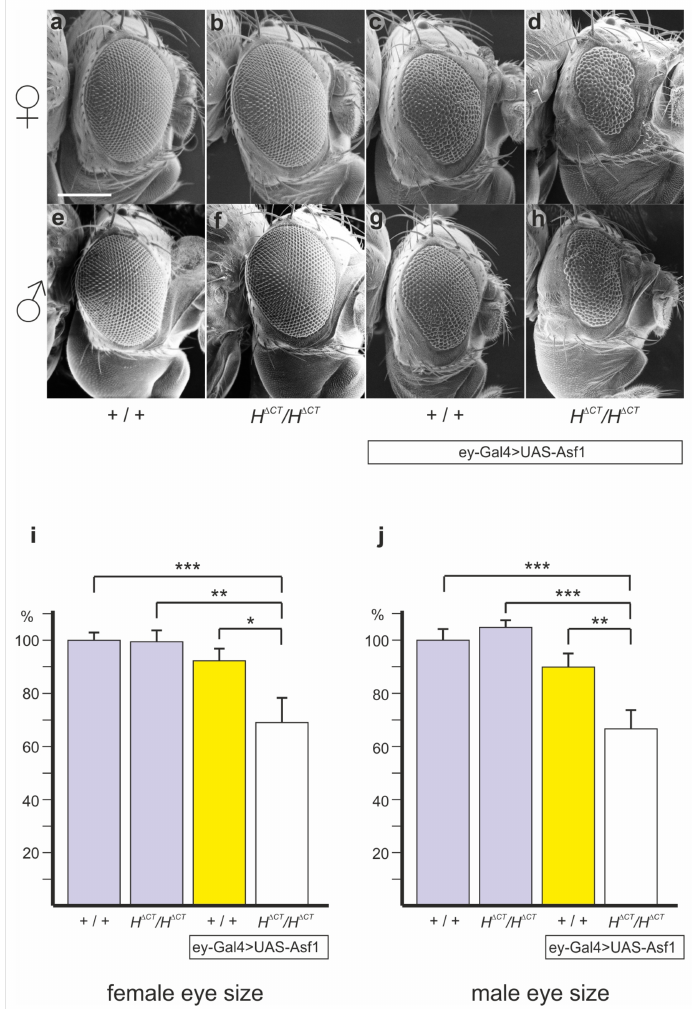
Figure 8. Eye size reduction induced by ectopically expressed Asf1 is enhanced in the H ∆ CT back- ground. ( a – h ) Scanning electron micrographs from female and male fly heads of the indicated genotype. Note the eye size reduction upon tissue-specific induction of Asf1 ( c , d , g , h ). Scale bar, 200 µ m ( a – h ). ( i , j ) Quantification of the eye size from five female flies of the indicated genotype using Image J. Controls are the homozygous y 1 w 67c23 ( a ) and H ∆ CT flies ( b ) (lilac bars). Eye-specific expression of Asf1 reduced eye size ( c ) (yellow bar), which was significantly enhanced in the H ∆ CT background ( d ) (white bar). Significance was determined with ANOVA two-tailed Tukey–Kramer test for multiple comparisons (*** p ≤ 0.001; ** p ≤ 0.01; * p ≤ 0.05). Genotypes: y 1 w 67c23 / y 1 w 67c23 ( a ), y 1 w 67c23 / y 1 w 67c23 ; H ∆ CT / H ∆ CT ( b ), y 1 w 67c23 /+ or Y; ey-Gal4 UAS Asf1/+ ( c , g ), y 1 w 67c23 / y 1 w 67c23